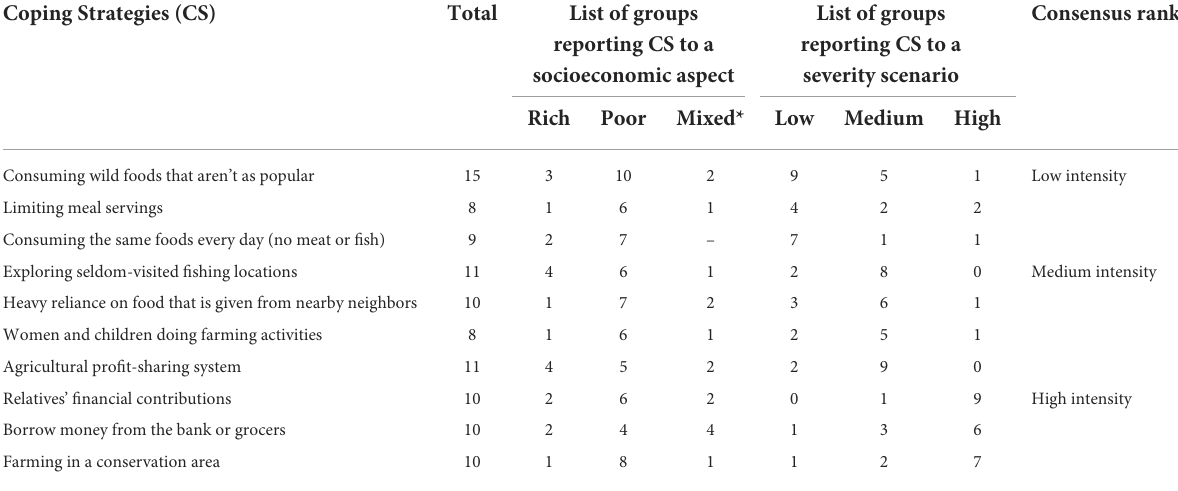
TABLE 3 Allocation of coping methods by socioeconomic aspect and severity scenario. Coping Strategies (CS) Total List of groups